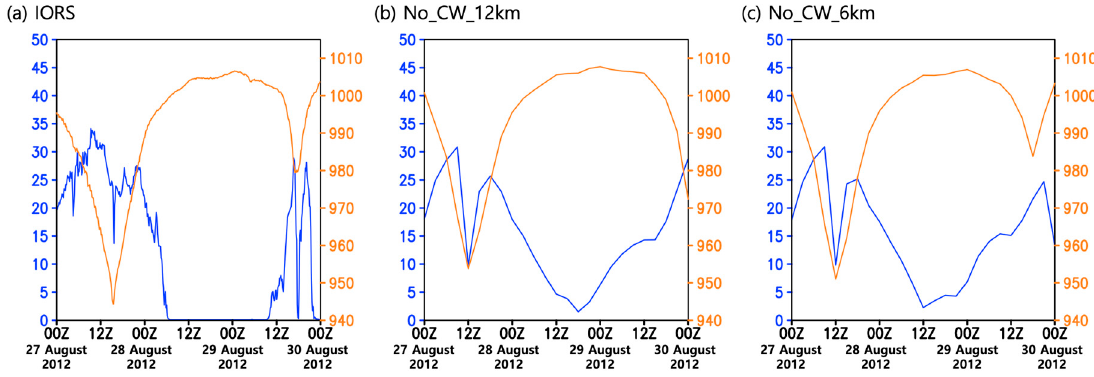
Figure 3. Time series of sea level pressure (right y-axis, orange, unit: hPa) and 10 m wind speed (left y-axis, blue, unit:m / s) at ( a ) IORS, ( b ) No_CW_12 km experiment, and ( c ) No_CW_6 km experiment.